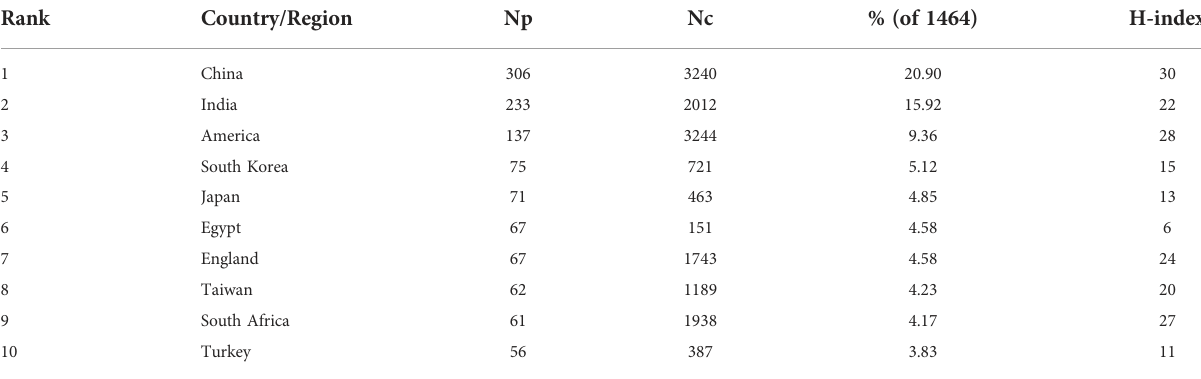
Np, number of publications; Nc, number of